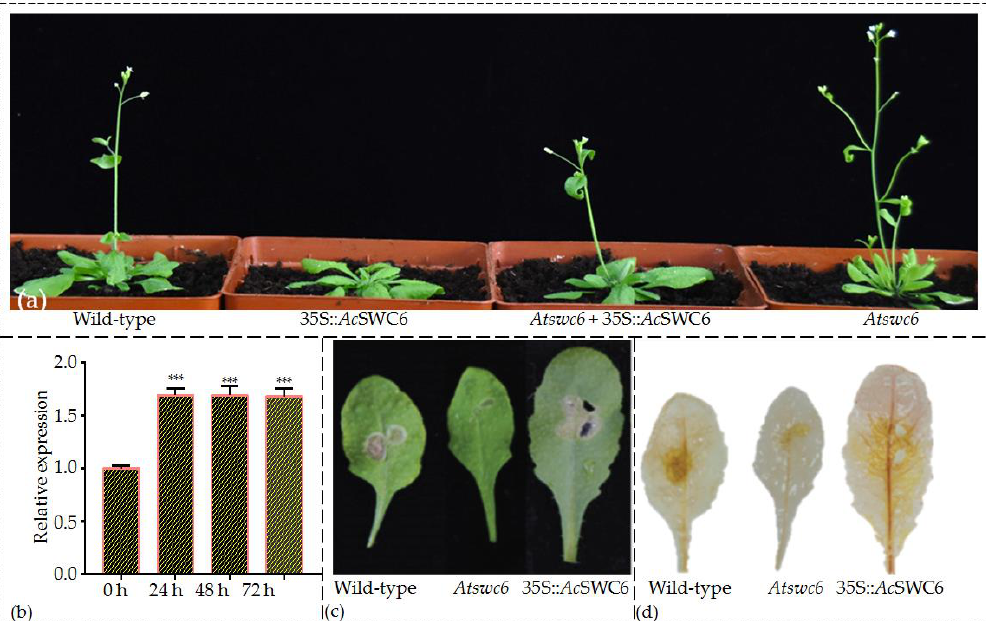
Figure 7. Ac SWC6 regulates the biotic stress tolerance in Arabidopsis : ( a ) Morphology of four-week-old wild-type (Col-0) and Ac SWC6 overexpressing plant; ( b ) Relative expression of Ac SWC6 in pineapple leaf at different time points after infection with fungus ( Sclerotinia sclerotiorum ); ( c ) Damage in leaves by fungus ( Sclerotinia sclerotiorum ) to mature rosette leaves of wild-type and Ac SWC6 overexpressing plants after 24 h infection; ( d ) Detection of H 2 O 2 by DAB staining in leaves of wild-type (Col-0) and Ac SWC6 overexpressing plants after 24 h infection. The brown color reflects the reactive oxygen species (ROS) accumulation after the fungal treatment.